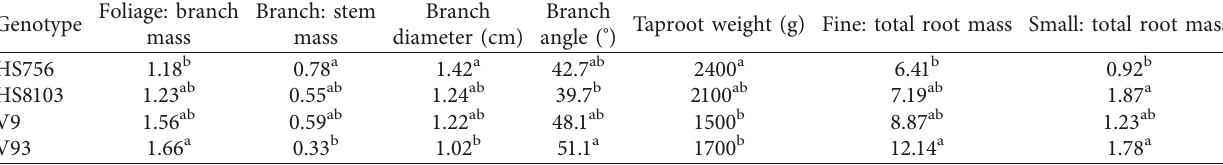
For each parameter, means within a column followed by different letters are different at P < 0 .